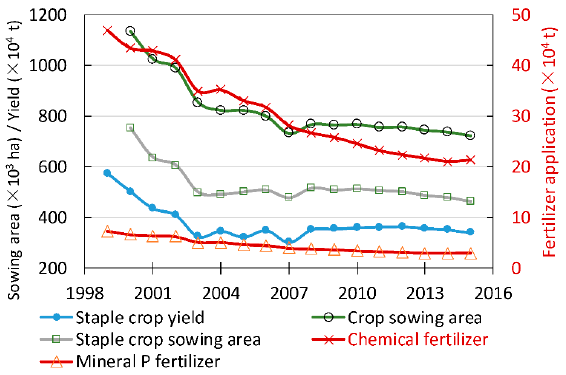
Figure 9. Changes in crop sowing area, crop yield, and amount of chemical fertilizer application since 1999 (data sourced from the Jiangsu Bureau of Statistics, http://tj.jiangsu.gov.cn/).